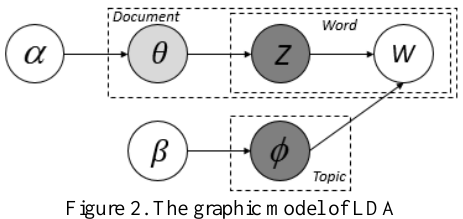
Figure 2. The graphic model of